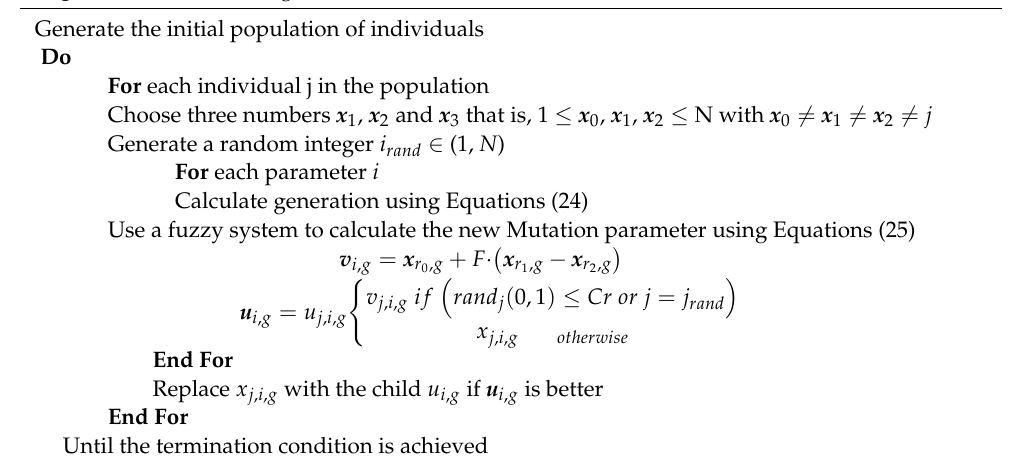
Figure 1. Diagram of the general proposal with general type 2 fuzzy systems for controlling a mobile robot and a performance comparison with interval type 2 and type 1 fuzzy systems. Algorithm 2. GT2FDE